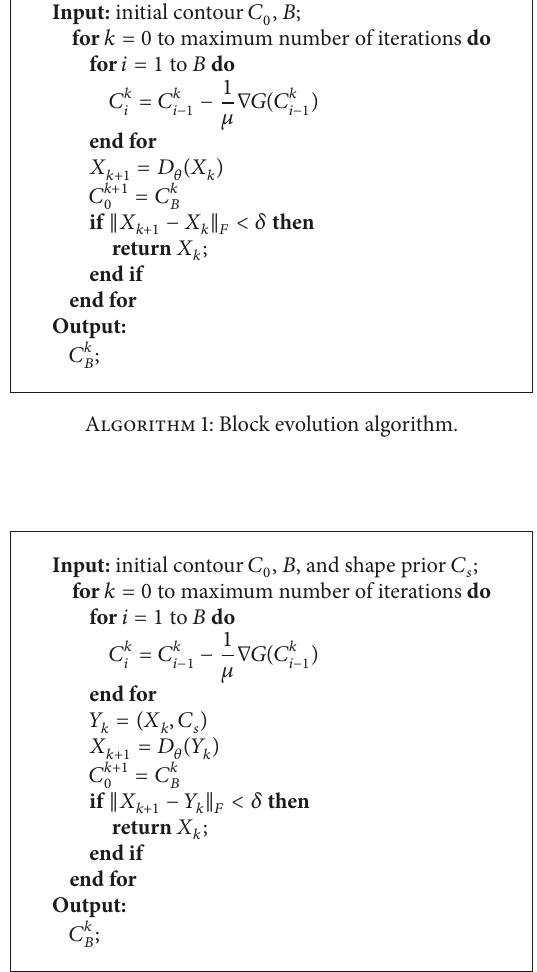
Algorithm 2: Block evolution algorithm for active contour model with shape